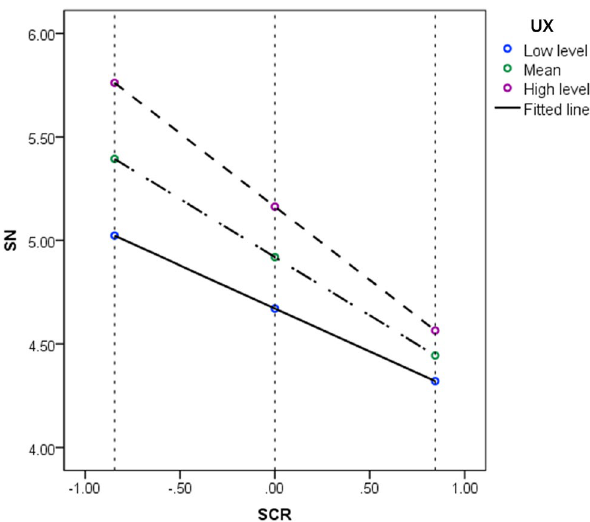
Figure 4. Moderating effect of user experience